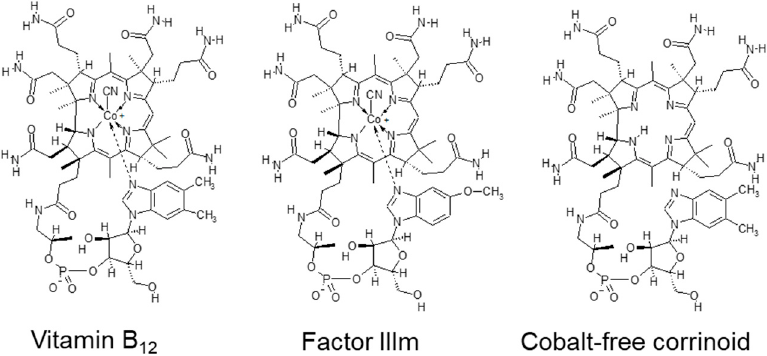
Figure 4. Chemical structures of vitamin B 12 and related compounds found in commercially available Chlorella products. Abbreviations: Factor IIIm, 5-methoxybenzimidazolylcobamide.